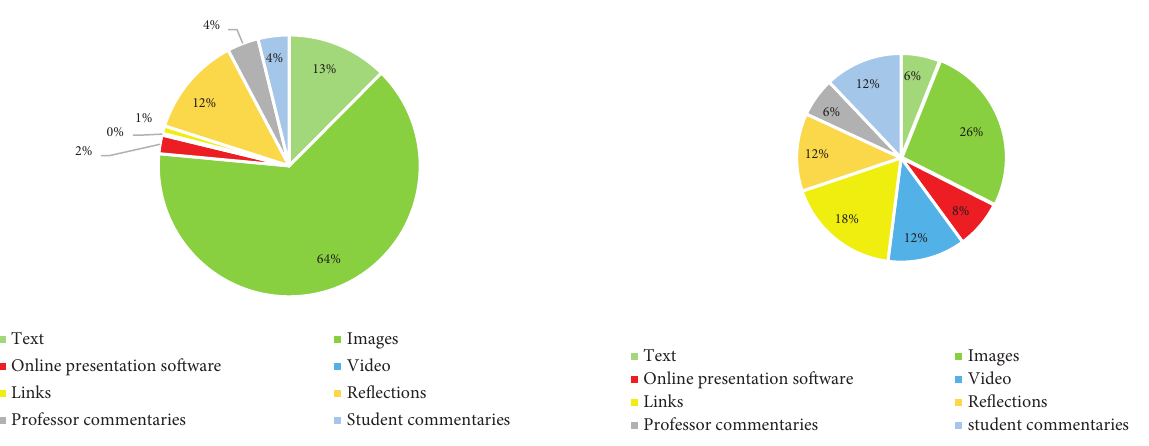
Figure 4. Evidences distributions comparison between analysis of the e-portfolio use and the proposed